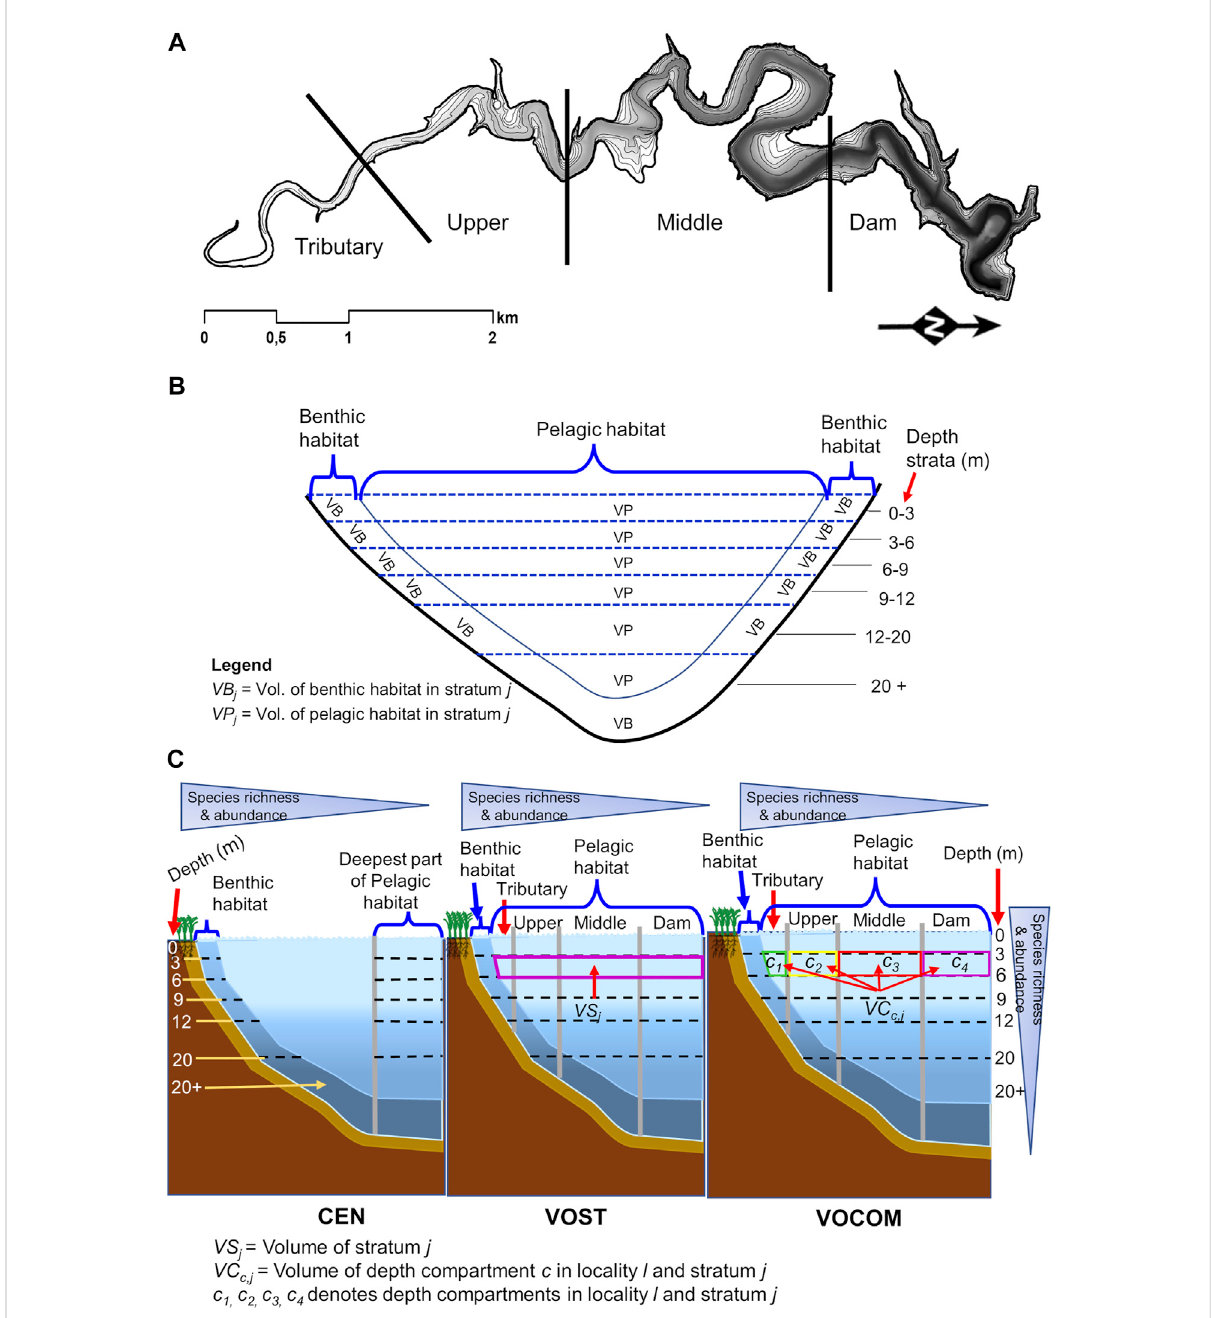
FIGURE 1 Map of Ř ímov Reservoir with depth contours and four reservoir localities (A) , schematic representation of habitat de fi nitions on the reservoir transversalcross-sectionwithdepthstrataformiddleanddamlocalitiesasanexample (B) ,andschematicrepresentationofhabitatsonthereservoir cross-sectionwithdepthstrataandgillnetsettingsofthethreemethods(CEN,VOSTandVOCOM) (C) .ThecolordepthofthegrayshadinginpanelA indicates the depth of the reservoir, and the contour lines refer to the investigated depth strata starting from 0 to 3 m. The number of depth strata decreases from the dam (the deepest point) to the tributary. CEN refers to the European Committee for Standardization protocol, VOST is a method that weights catch rates using the volume of the depth stratum relative to the volume of the reservoir, while VOCOM is a method that weights catch rates using the volume of the depth compartment in each locality and stratum relative to the volume of the